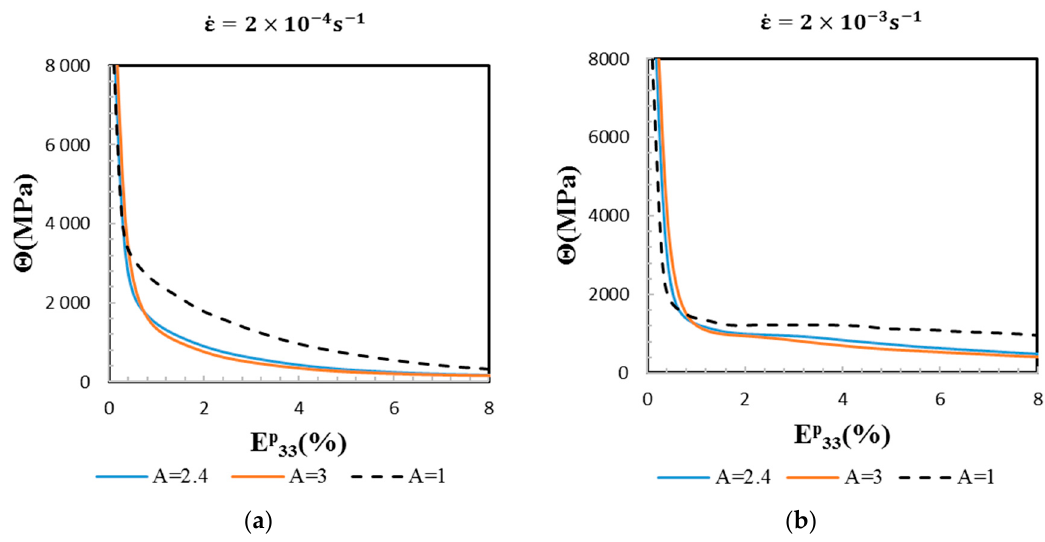
Figure 3. Comparison of overall strain-hardening rate evolutions as a function of macroscopic strain for different anisotropy factors (A = 1, 2.4 and 3) and at two tensile applied strain rates (cid:1) (2 × 10 (cid:2879)(cid:2872) s (cid:2879)(cid:2869) ((cid:1801)) and 2 × 10 (cid:2879)(cid:2871) s (cid:2879)(cid:2869) ((cid:1802))) . 2 × 10 − 4 s − 1 ( a ) and 2 × 10 − 3 s − 1 ( b )